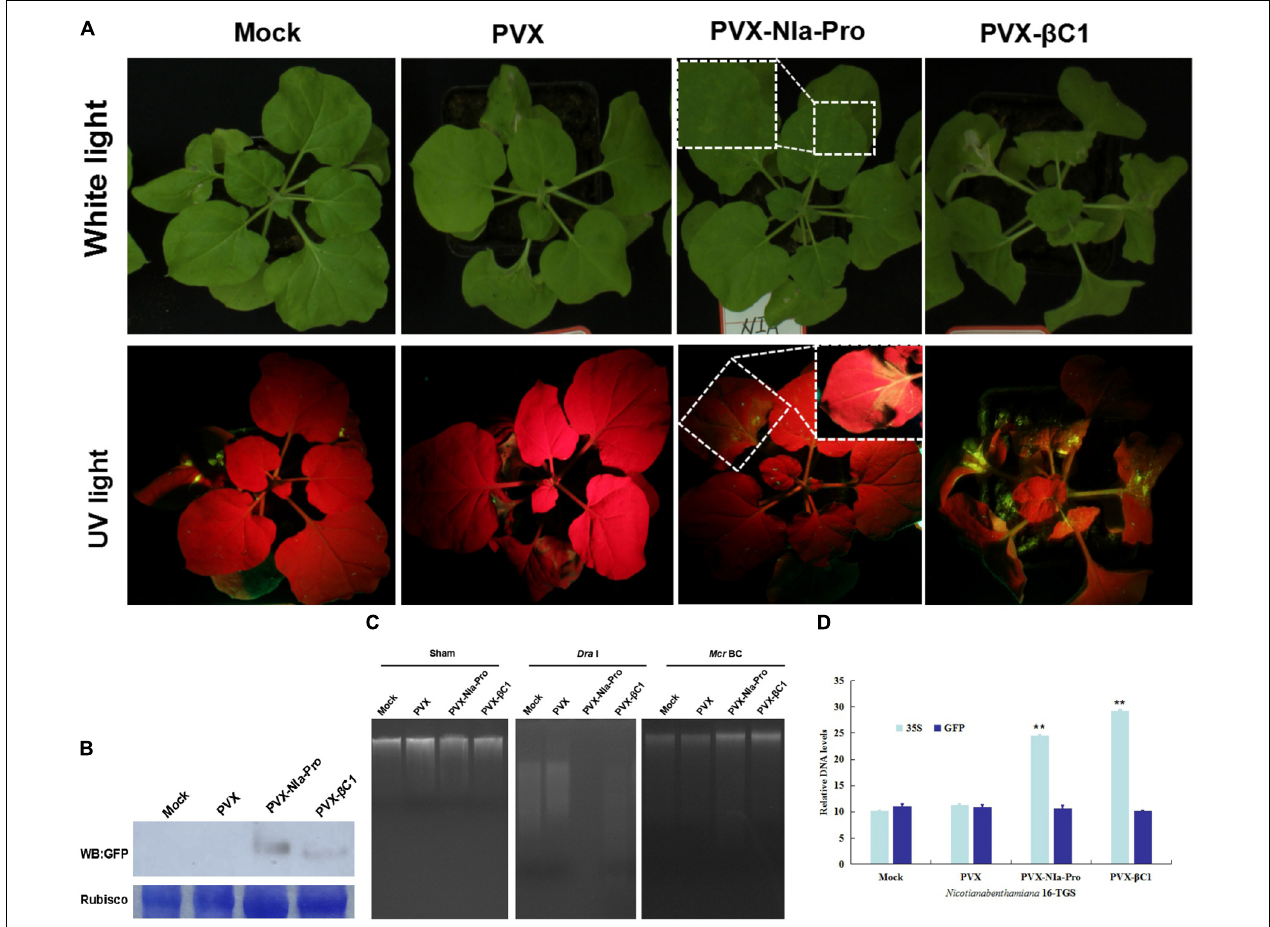
FIGURE 5 | NIa-Pro inhibits transcriptional gene silencing (TGS) of a green fluorescent protein (GFP) transgene and suppresses DNA methylation. (A) Nicotiana benthamiana 16-TGS plants were mock-inoculated or inoculated with potato virus X (PVX), PVX-NIa-Pro, or PVX- β C1 (positive control), and leaves were photographed under white light or UV light at 14 days post inoculation (dpi). (B) Western blotting assay of GFP protein accumulation in systemically infected leaves shown in panel (A) . Coomassie blue staining of the large subunit of Rubisco was used as loading controls for Western blotting. (C) DNA methylation analysis by restriction enzyme digestion in NIa-Pro-expressing N. benthamiana plants. Genomic DNA extracted from systemically infected leaves shown in (A) was digested with the methylation-dependent restriction enzyme Mcr BC and the methylation-insensitive enzyme Dra I. “Sham” indicates a mock digestion with no enzyme included. (D) qPCR analysis of DNA levels from systemically infected leaves shown in panel (A) was digested with the methylation-dependent restriction enzyme Mcr BC. Values are the mean ± SD. Highly significant differences ( ** p < 0.01) between samples in each pair are